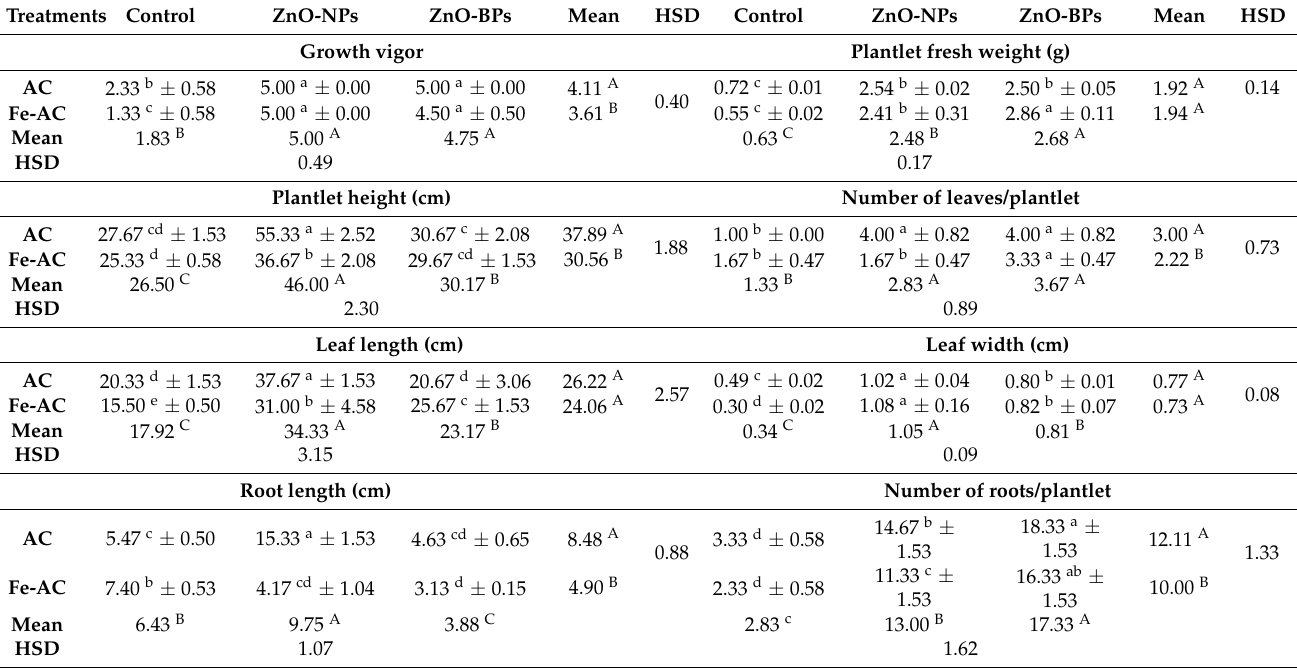
Table 2. Effect of activated charcoal (AC), Fe-modified activated carbon (Fe-AC), zinc oxide nano- particles (ZnO-NPs), and zinc oxide bulk particles (ZnO-BPs) and their combinations on some morphological parameters of date palm cv. Medjool grown in vitro. Five plantlets for each treatment were utilized for 10 weeks of